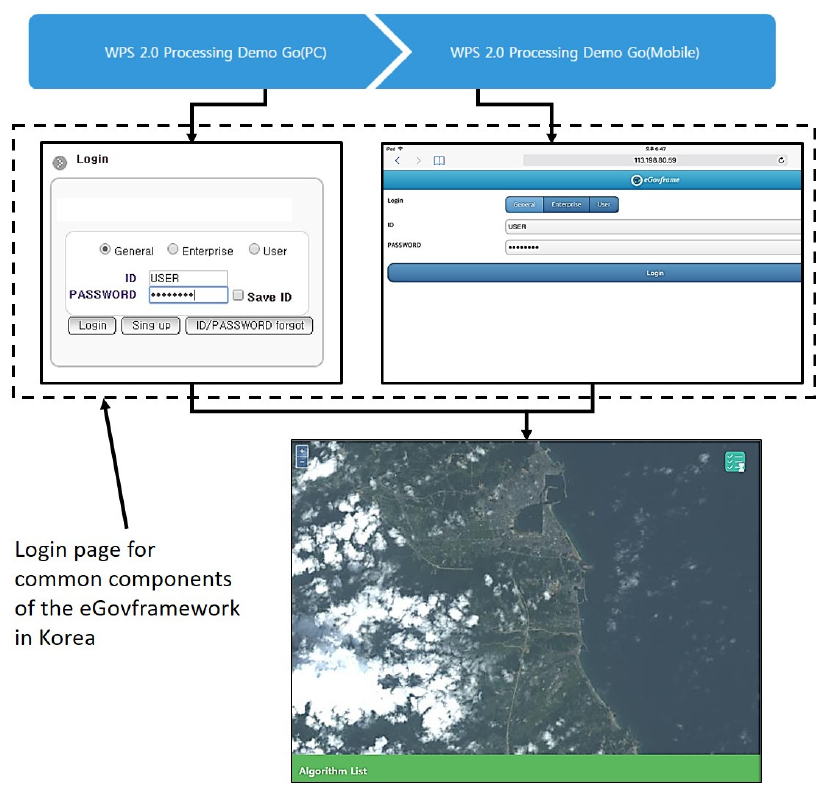
Figure 3. Automatic loading of additional common components by user authentication.